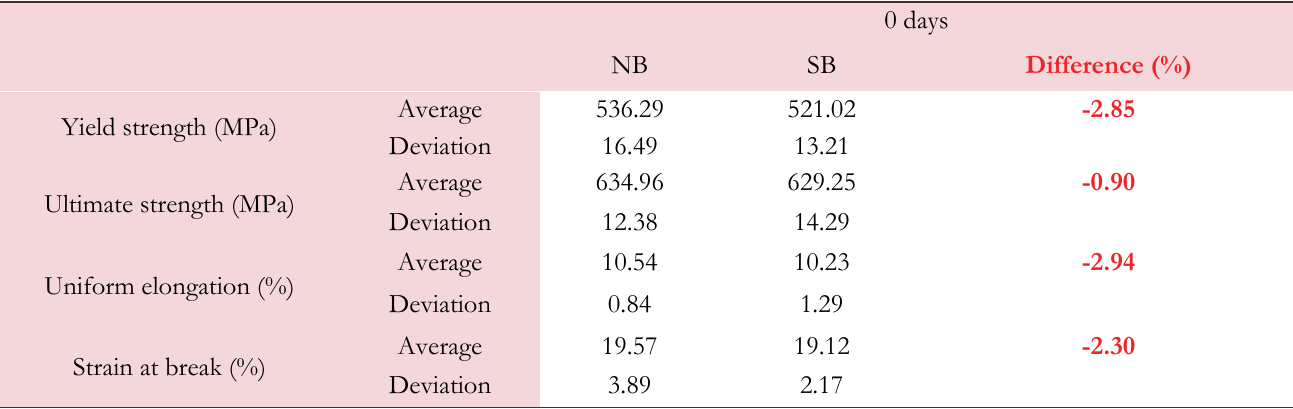
Table 6: Tensile results values and comparison.